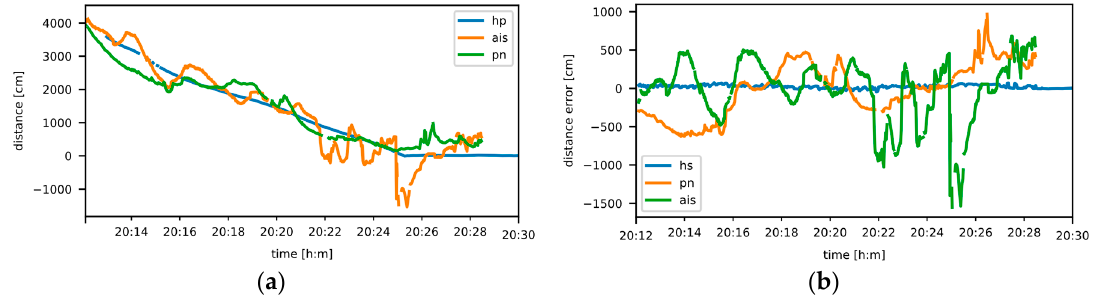
Figure 5. Comparison of LIDAR reference, ship and pilot navigation system ( a ) and distance errors of ship GPS, pilot navigation system and worst LIDAR ( b ).